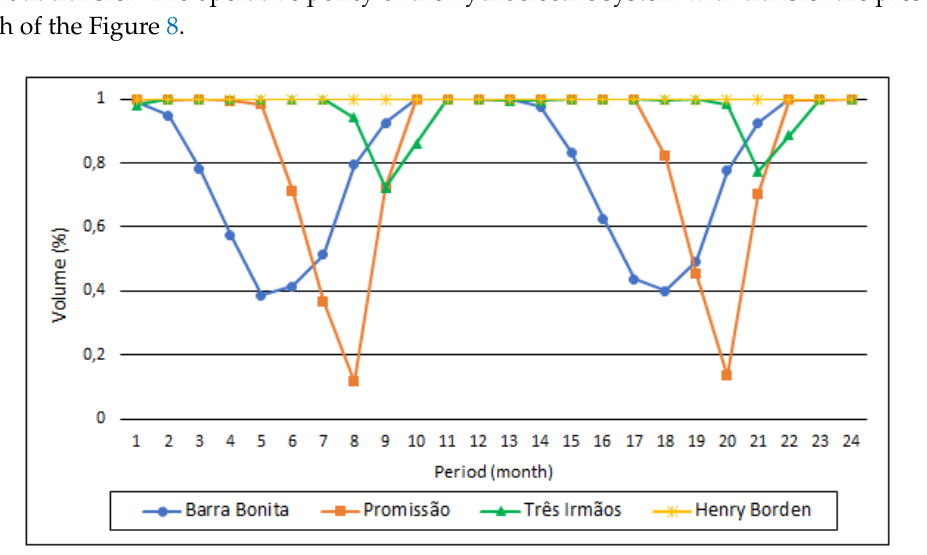
Figure 8. Volume trajectory of plants for 100% Long-Term Average (LTA) with water